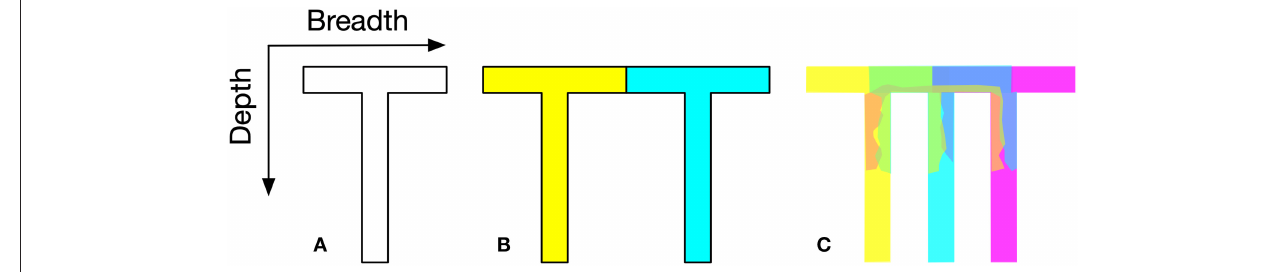
FIGURE 1 | Subject-matter depth and breadth in transdisciplinary education. In typical disciplinary education models of most universities (A) , individuals are encouraged to seek depth in their field, with some breadth in related areas, as represented by the T-bar shape (Enders and de Weert, 2009; Karjalainen et al., 2009; Oskam, 2009; Barile et al., 2012; Barile and Saviano, 2013; Harris et al., 2013; Sanchez et al., 2016). Multidisciplinary research (B) lines up multiple students, from multiple disciplines (represented by color) on common projects, but limits them to showing depth and breadth within their respective fields. Transdisciplinary research, as advocated here (C) , seeks to ensure that students have the tools to appreciate and build upon their peers in other disciplines. Their T-bars are closer, their disciplinary boundaries are removed, and knowledge permeates, revealing new shades of disciplinary integration, and thus new potential achievements by the